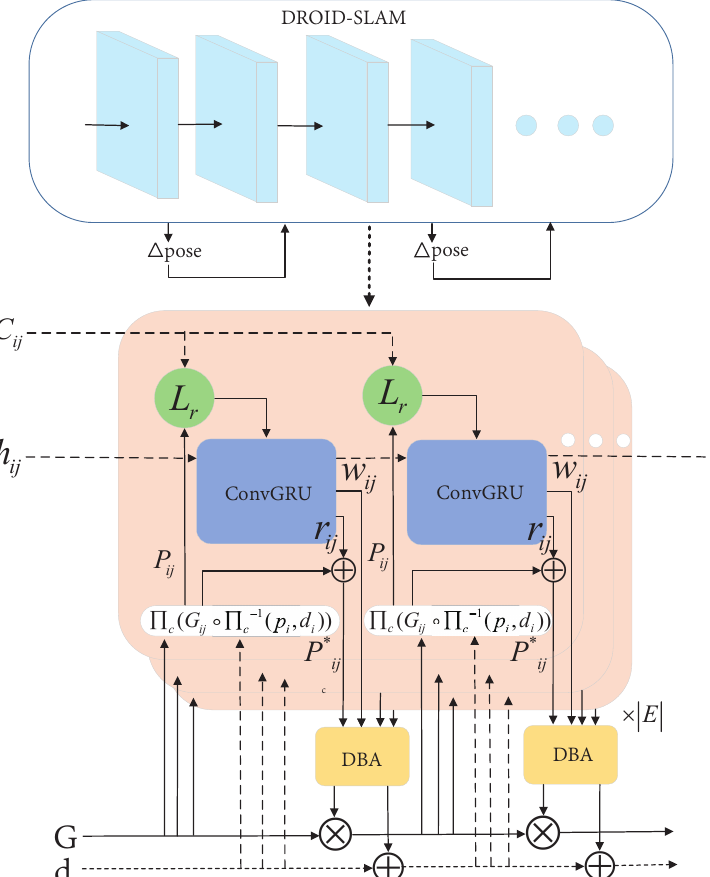
Figure 16. The core framework of